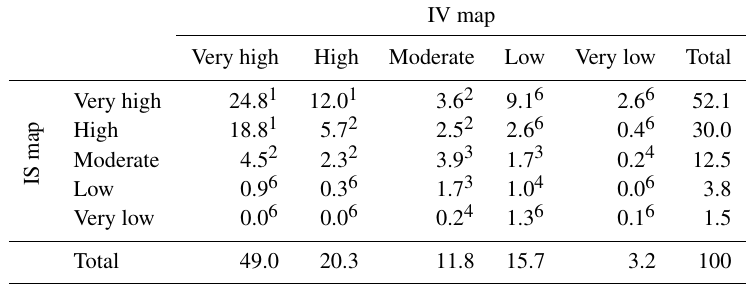
Table 7. Distribution (%) of shallow slides of the validation group in classes obtained by overlay IV and IS shallow slide susceptibility